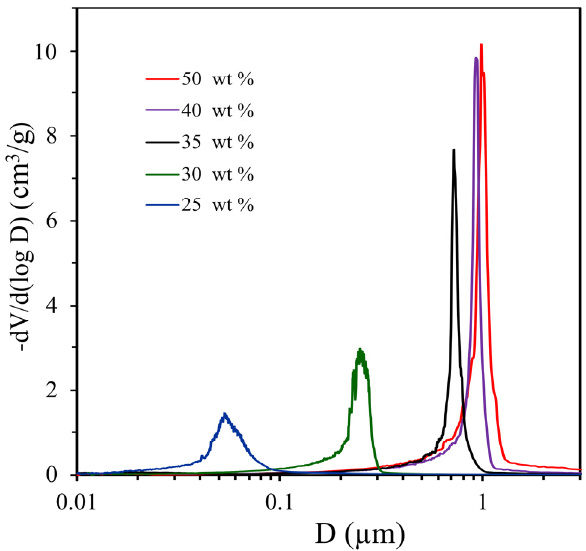
Figure 5. The pore size distribution of poly-OCM-2 (M8–M12) obtained from OCM-2 in the presence of 1-butanol (25–50 wt %).